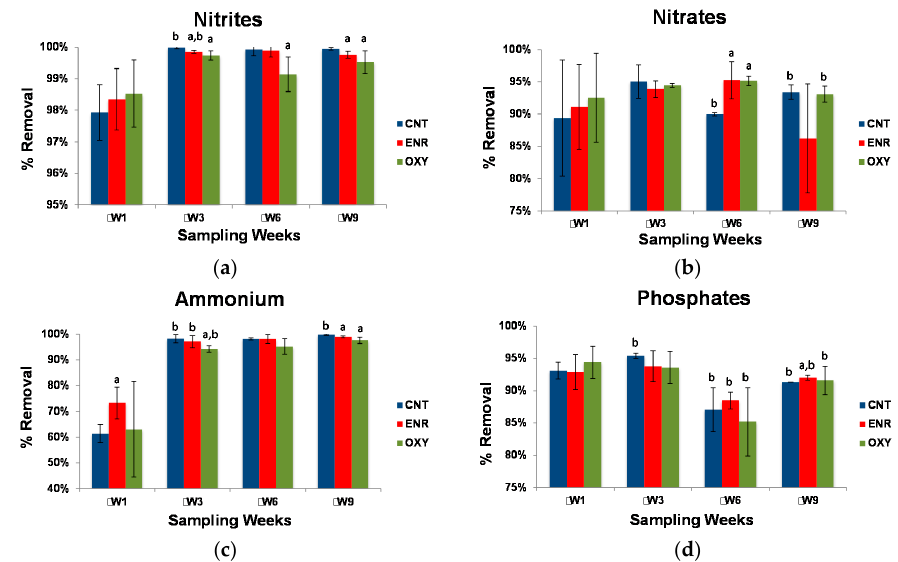
Figure 4. Inorganic nutrient removal percentages, in percentage, along the sampled weeks: ( a ) Nitrites; ( b ) Nitrates; ( c ) Ammonium; and ( d ) Phosphates. Wastewater not doped (CNT) or doped with the antibiotic enrofloxacin (ENR) or oxytetracycline (OXY). a: Significant ( p < 0.05) differences compared to CNT; b: Significant ( p < 0.05) differences compared to the same treatment the week before. Values of Fe varied between 0.318 and 0.549 mg/L in initial wastewaters. Removal percentages varied between − 120% and 70%, indicating both exportation and removal of Fe occurred within the CWs systems, along time. Significant ( p < 0.05) differences were registered between W1 and W3 for CNT treatments and between W6 and W9 for ENR and OXY treatments. Significant ( p < 0.05) differences were observed between treatments in W9. All values complied with the Portuguese legislation for wastewater discharge (2.0 mg/L)